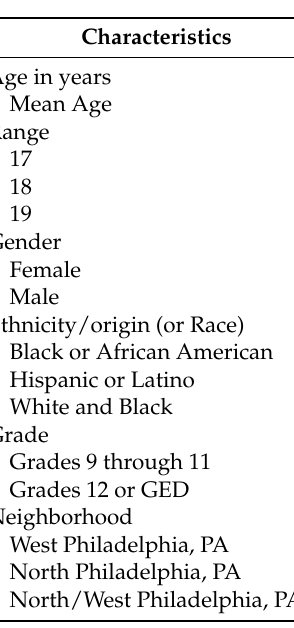
Table 1. Frequency Distribution of Selected Demographic Variables Youth.